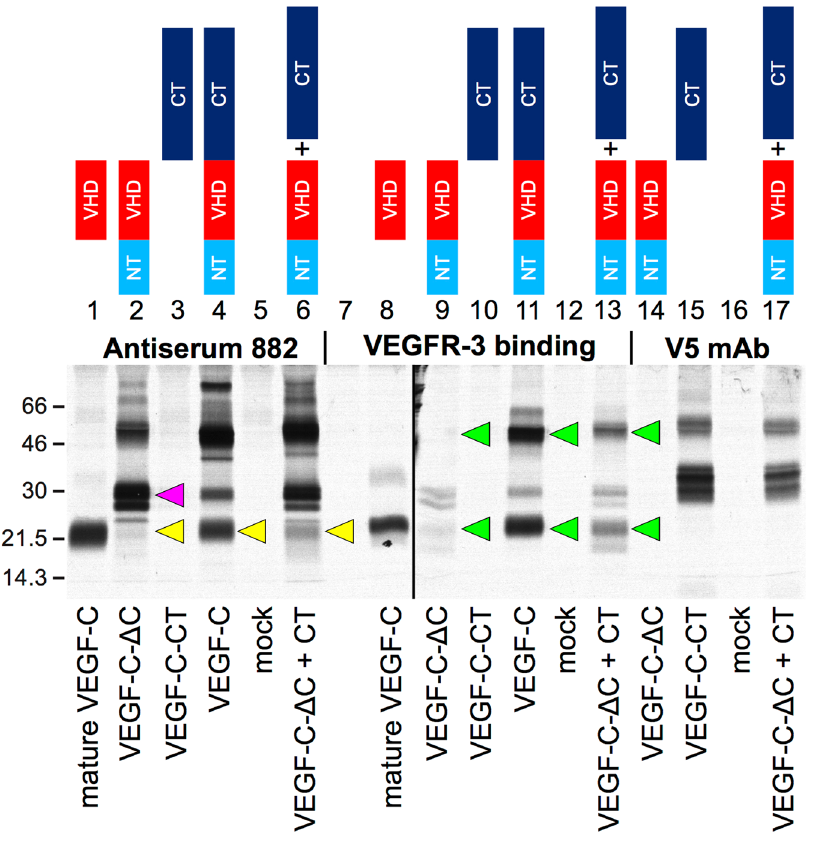
Figure 3. The VEGF-C C-terminus rescues proteolytic processing and receptor binding of VEGF-C- Δ C in vitro . Processing of pro-VEGF-C (magenta arrow) into mature VEGF-C (yellow arrows) and the ability to bind to VEGFR-3 (green arrows) are reduced when the C-terminus is omitted from VEGF-C. VEGF-C cleavage (lane 6) and its VEGFR-3 binding pattern (lane 13) are normalized when VEGF-C- Δ C is co-expressed with VEGF- C-CT. Metabolically labeled proteins were precipitated from the conditioned medium of transfected 293 T cells with VEGFR-3-Ig fusion proteins, with antiserum 882 or with anti-V5-antibody (VEGF-C-CT is V5-tagged) and analyzed by 12% SDS-PAGE under both reducing and non-reducing conditions. The full length Western blots are shown in Supplementary Fig.